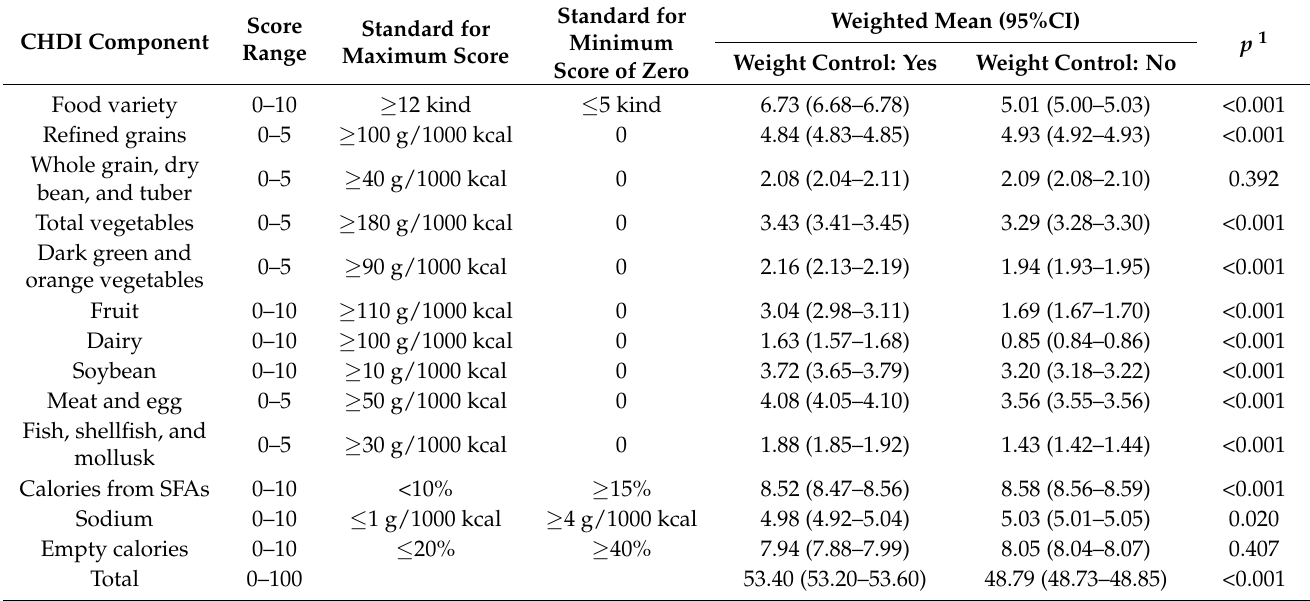
The data were weighted to be nationally representative. Abbreviations: CHDI, China healthy diet index. SFAs, saturated fatty acids. 1 The p value was obtained using general linear models adjusted for gender, age, body